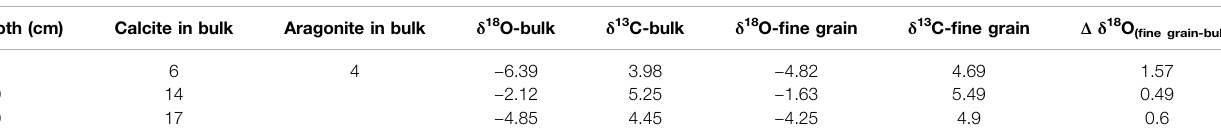
TABLE 4 | Isotopic comparisons of bulk and fi ne-grained carbonates ( ‰ VPDB) Depth (cm)